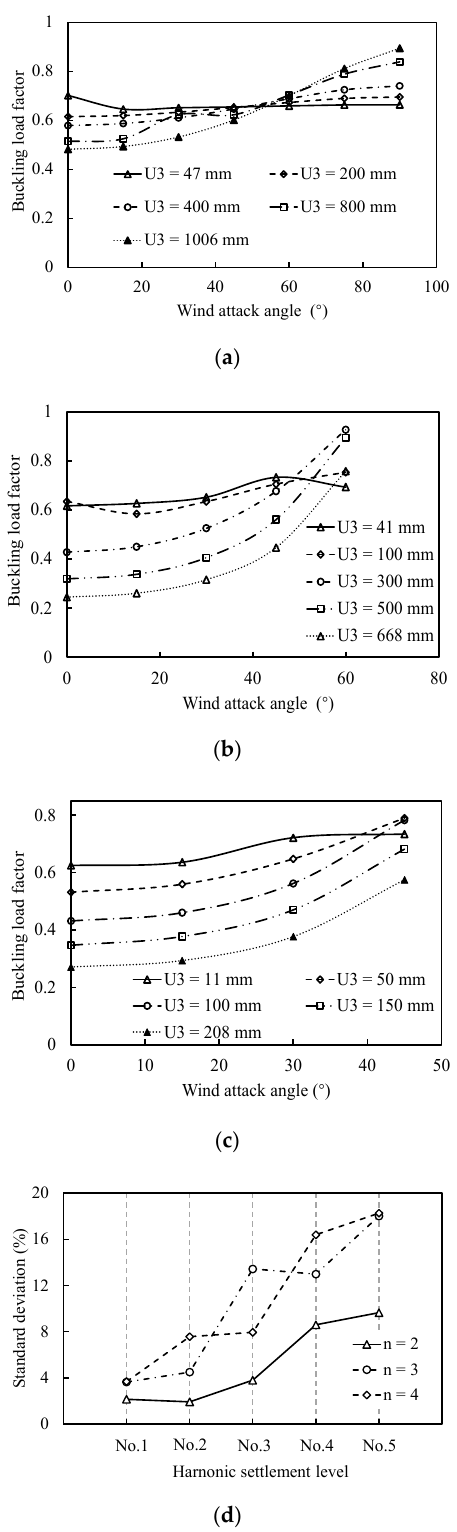
Figure 17. Wind attack angle versus buckling load factor: ( a ) n = 2; ( b ) n = 3; ( c ) n = 4; ( d ) Standard deviations versus harmonic settlement